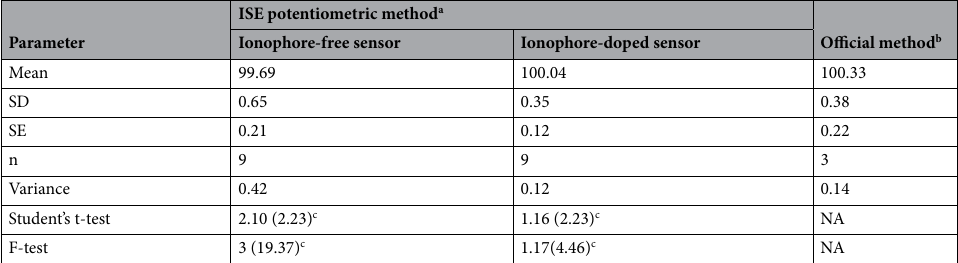
Table 3. Statistical comparison between the results obtained by the proposed ISE potentiometric method and the official method for determination of PALO in its pure form. a 9 determinations of 3 concentration levels by the proposed ISE method. b 3 determinations of 3 concentrations by USP 41, HPLC–UV method for PALO. c The values in parentheses are the corresponding tabulated values of t and F at p = 0.05.